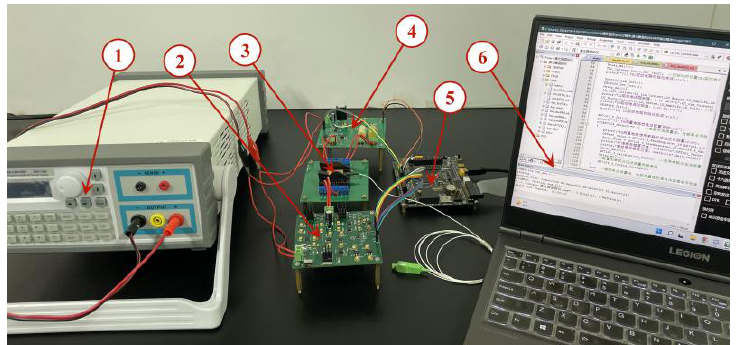
Figure 14. Semiconductor laser current drive and temperature control experimental system: (1) DC regulated power supply, (2) constant-current driver circuit, (3) butterfly semiconductor laser, (4) temperature control circuit, (5) microcontroller, and (6) PC.